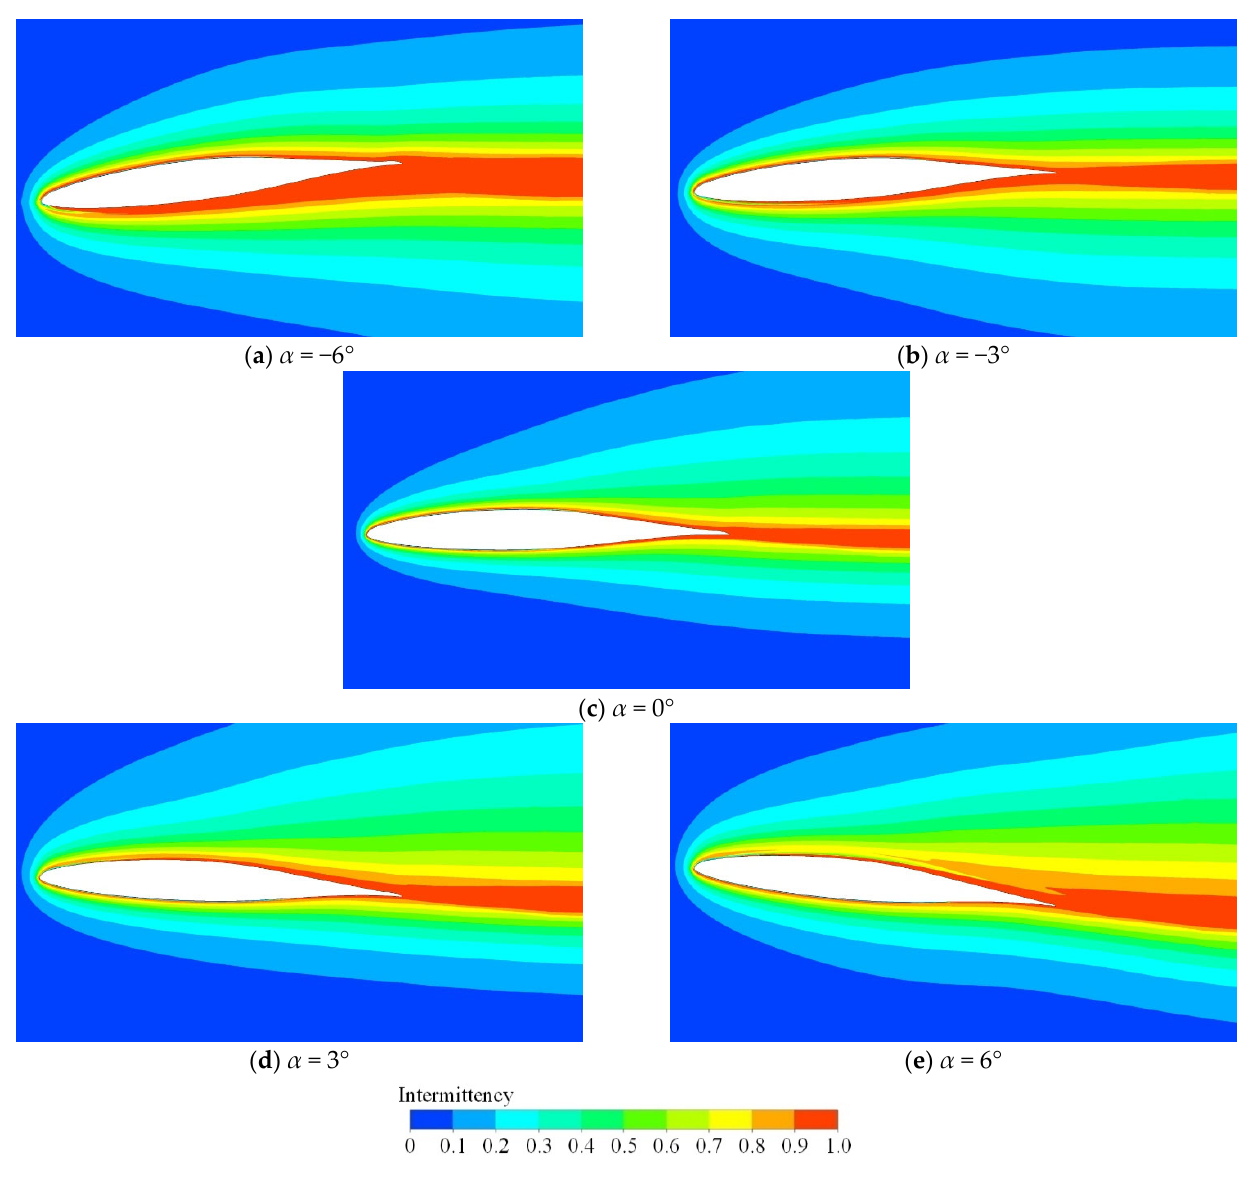
Figure 15. Influence of angle of attack on distribution of intermittency ( ε = 0.5%, T w = 293 K, Ma = 0.6).